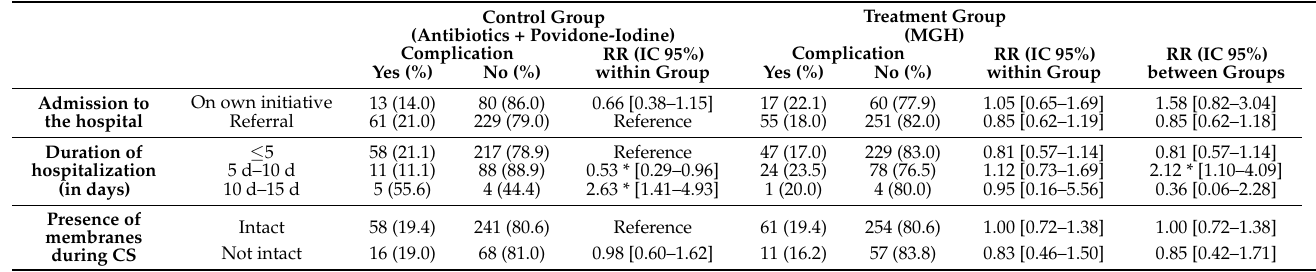
Table 6. Overview of distribution of complications by non-baseline-related factors in both groups. Both the control and treatment groups consisted of 383 patients, with 74 and 72 patients considered to have postoperative complications, respectively. Subgroups were based on the presence or absence of postoperative complications. * represents a significant difference ( p <